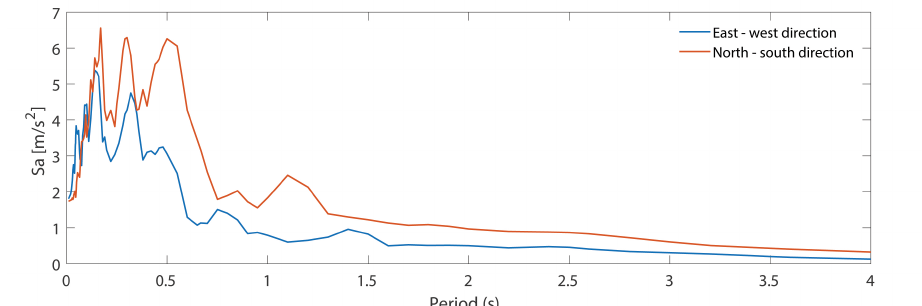
Figure 5. Acceleration response spectra of the Montenegro 1979 earthquake